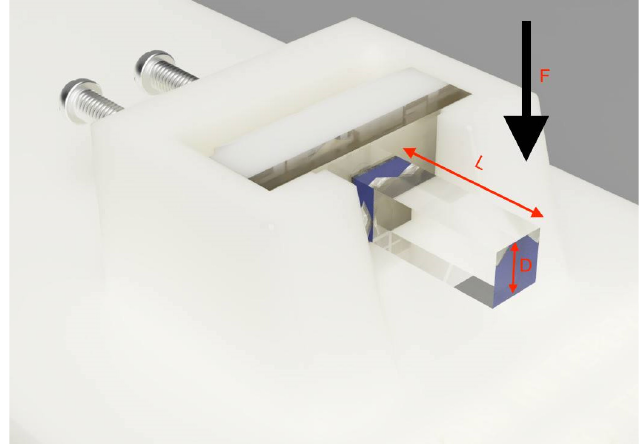
Figure 3. Image showing a schematic illustration of a bonded specimen in load configuration.